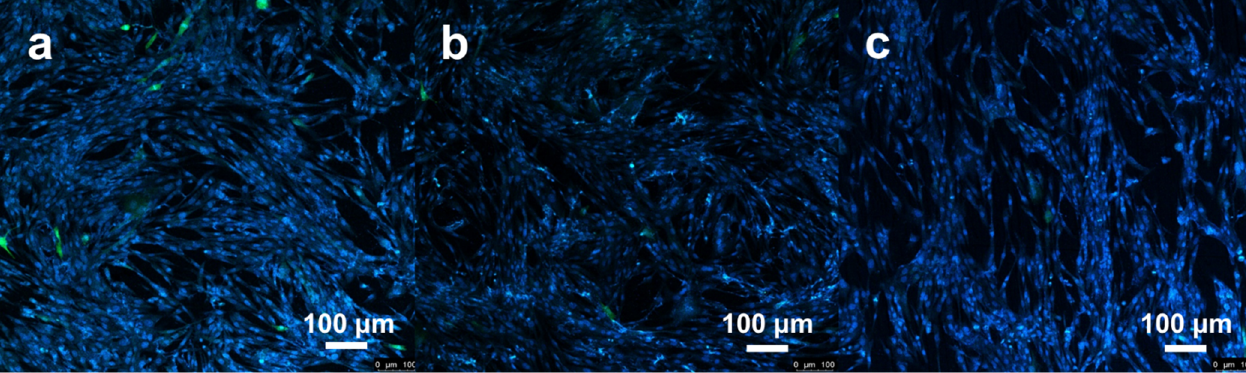
Figure 12. Fluorescence confocal images of surface cells in ( a ) blank control group, ( b ) substrate group, and ( c ) alloying layer group after 1, 3, and 7 days of proliferation.